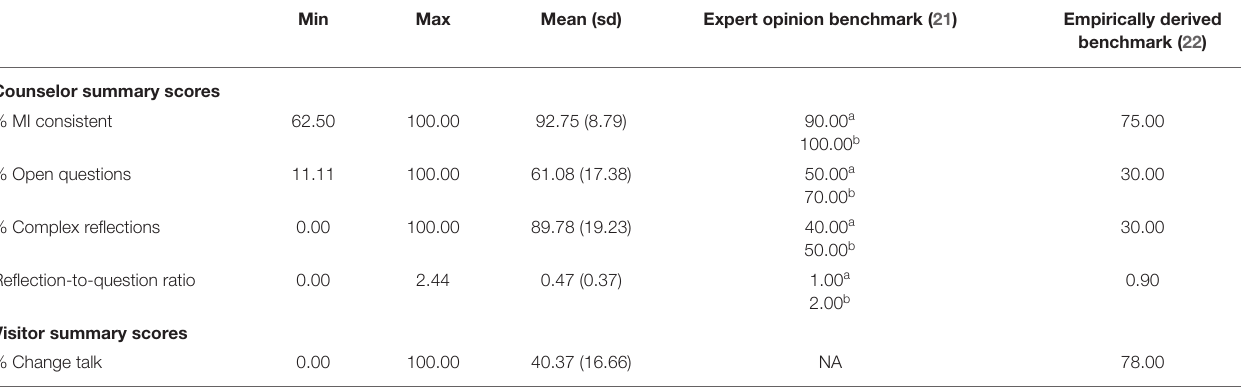
TABLE 5 | MI-SCOPE summary scores compared to benchmark criteria set forth by Moyers et al. (21) and Fischer